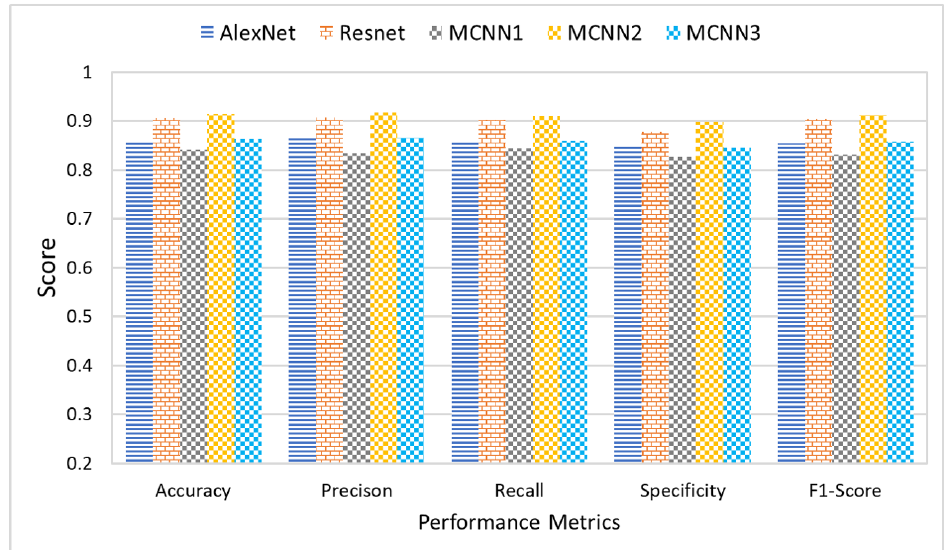
Figure 12. Comparative analysis of proposed and state-of-the-art DL techniques.